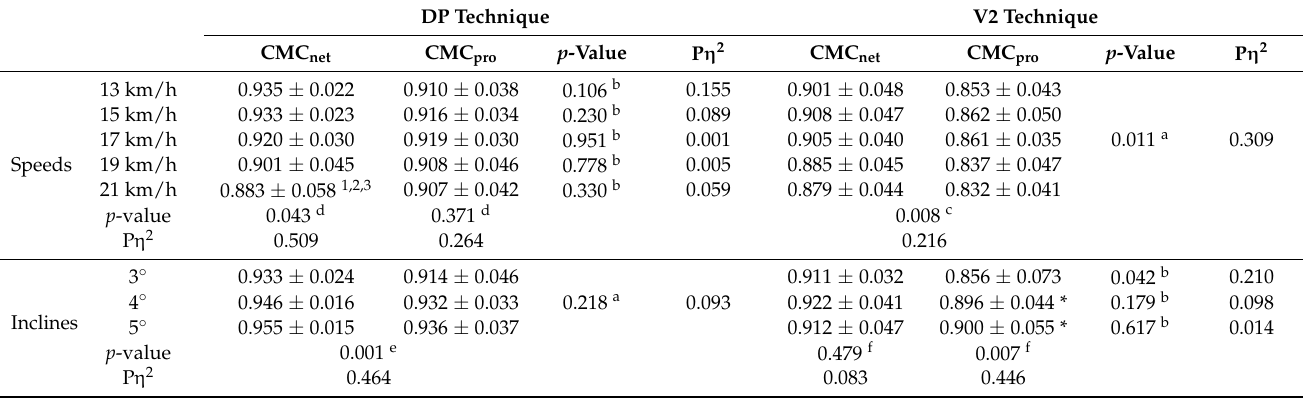
Table 1. Mean and standard deviation of the CMC for the DP technique ( n = 9) and the V2 technique ( n = 10).